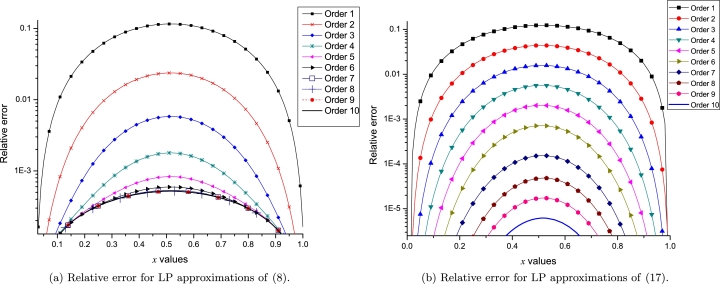
Relative error for different q-orders of LP. In fact, q means an order of [q,q].